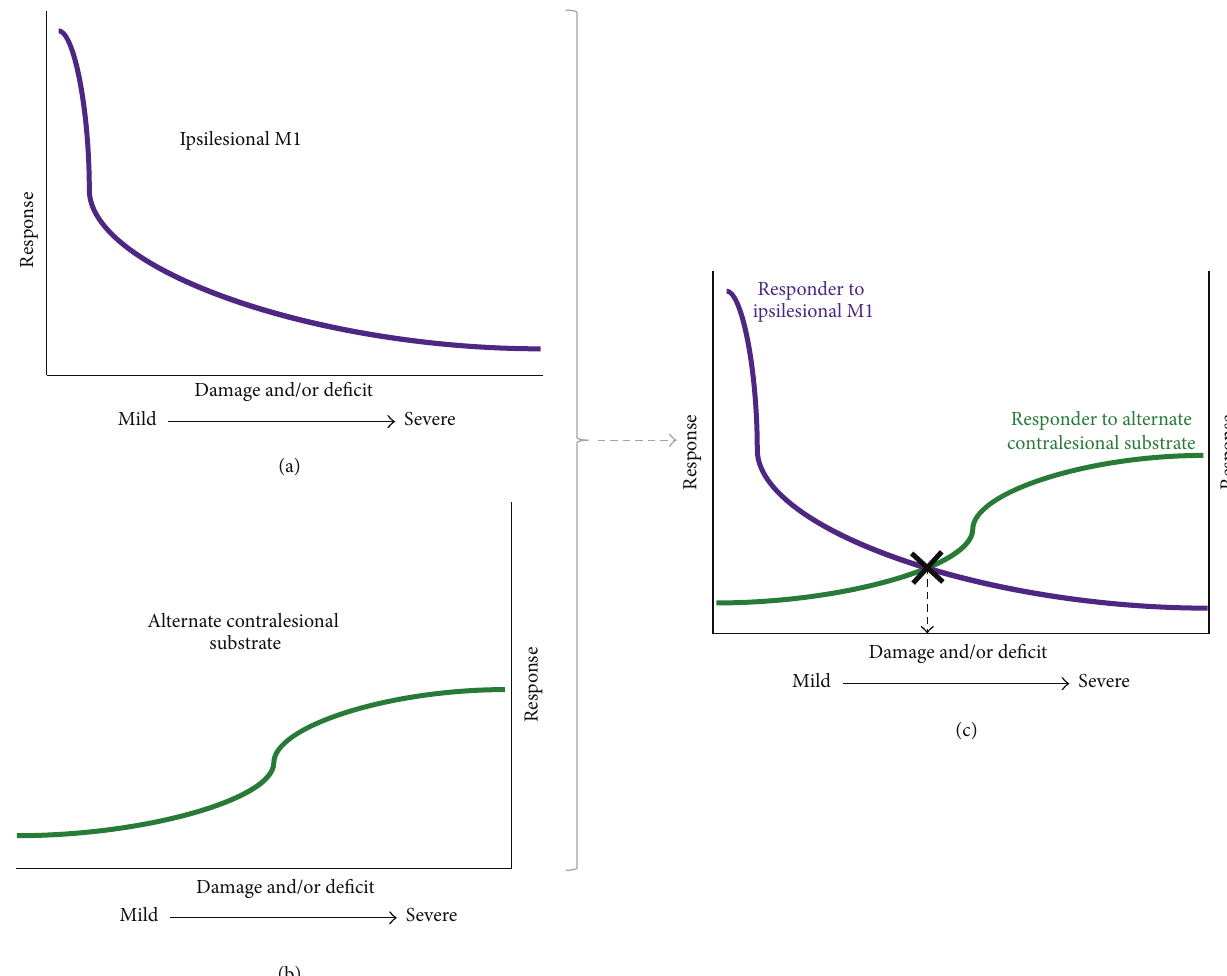
Figure 4: Bimodal model based on inherent expressions of plasticity. We propose a bimodal model that explains how to empirically derive a cut-off that separates responders for stimulation of the traditional substrate-ipsilesional M1 (a) versus stimulation of an alternate substrate in the contralesional cortices (b). Our proposed bimodal model of paretic upper limb recovery: cut-off derived empirically